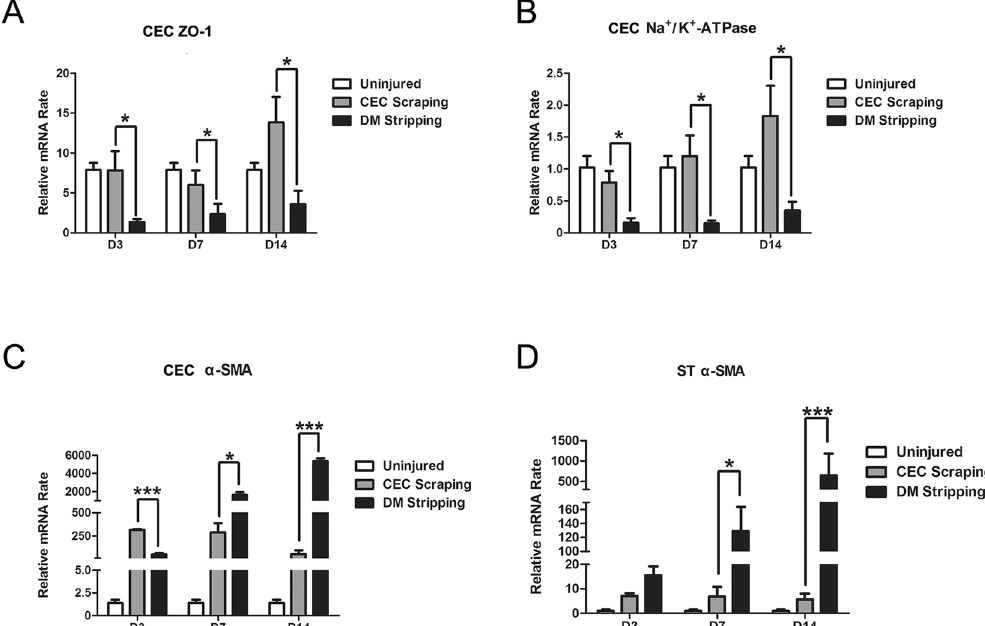
Figure 9. Gene expression in corneal endothelial cells and stromal cells after endothelial injury. ZO-1 gene expression in CECs after scraping injury was significantly higher than that in CECs after DM stripping at day 3, 7, and 14 ( A ). Na + /K + ATPase gene expression significantly decreased after DM stripping at day 3, 7, and 14 ( B ). α -SMA gene expression in CECs dramatically increased after scraping injury and DM stripping at day 3, 7, and 14. α -SMA expression was higher in CEC scraping group at day 3, while was higher in DM stripping group at day 7 and day 14 ( C ). α -SMA gene expression in central corneal stroma showed mild increase in CEC scraping group at day 3, 7, and 14. While there was dramatic increase in DM stripping group at day 7 and day 14 ( D ). ( * p < 0.05; ** p < 0.01; *** p <